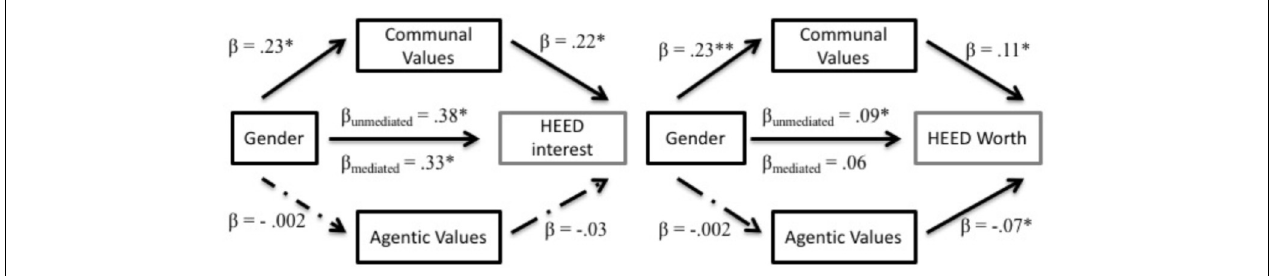
FIGURE 2 | Mediation models for HEED variables in Study 1. All mediators were entered simultaneously for each model. ∗ p < 0.05, ∗∗ p < 0.01.